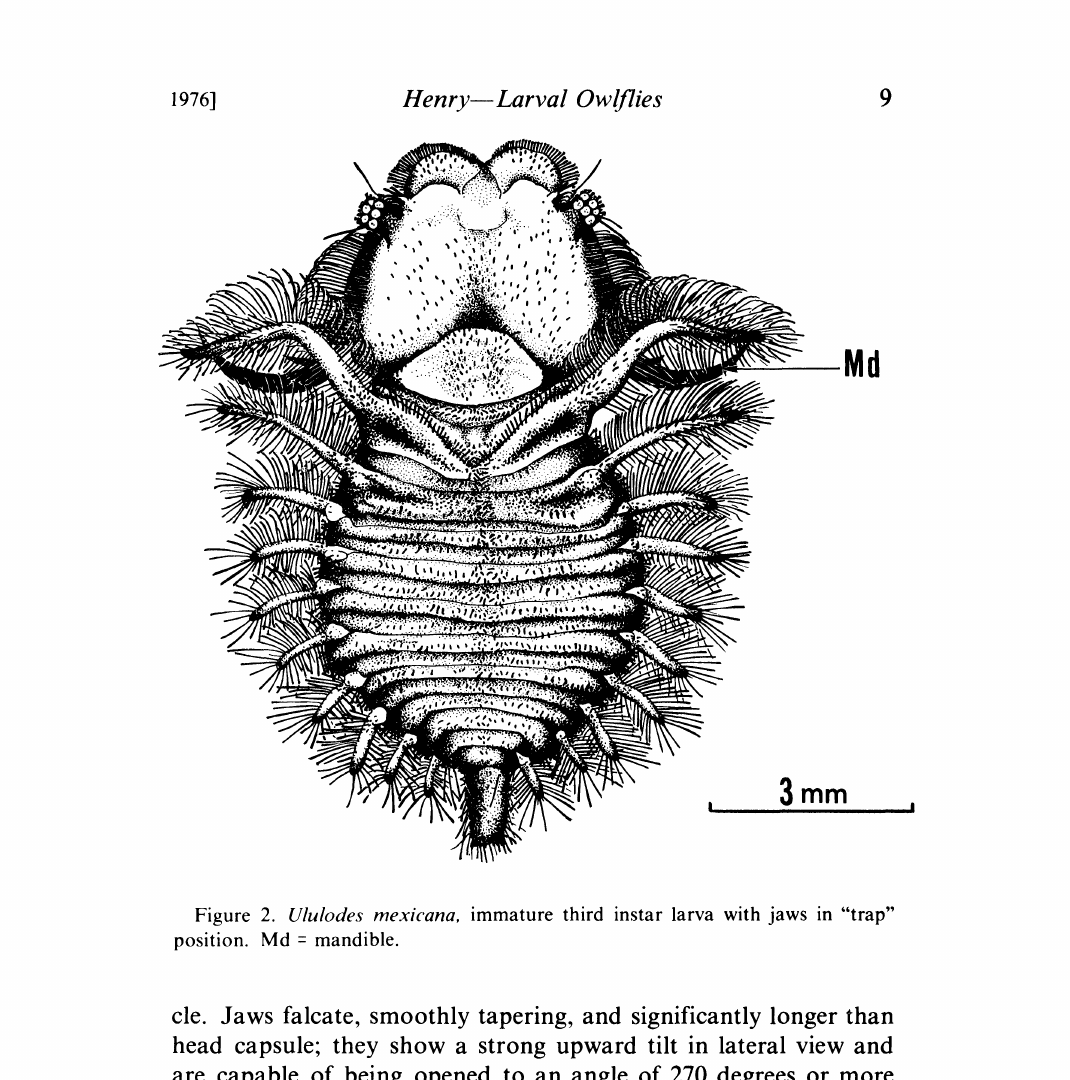
Figure 2. Ululodes mexicana, immature third instar larva with jaws in "trap" position. Md